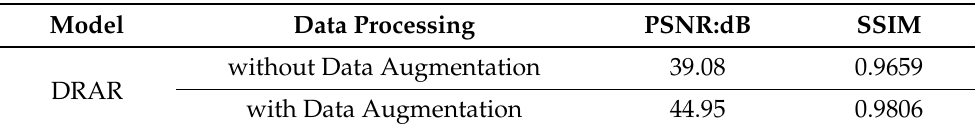
Table 3. Quantitative results of DRAR w/o augment and DRAR with augment. We report the best PSNR on the test